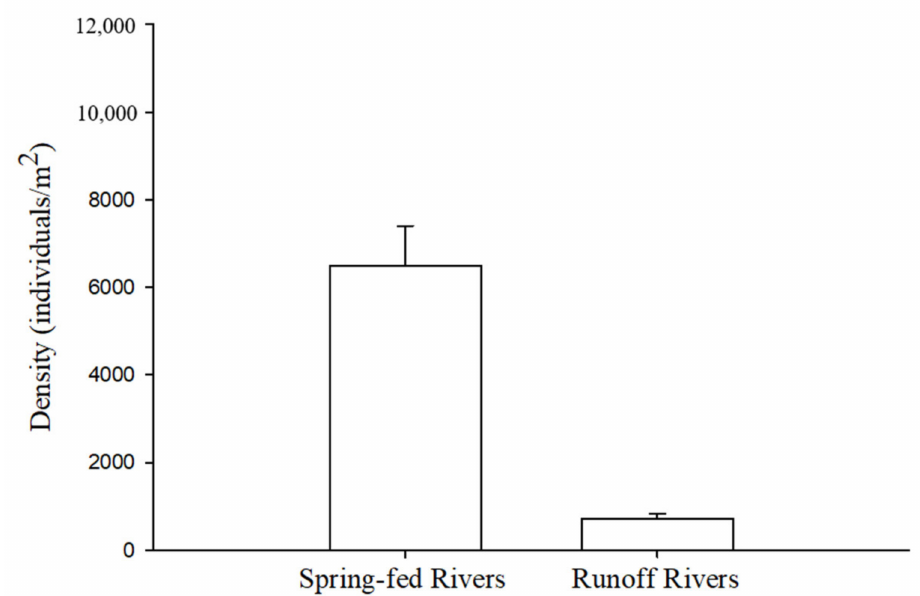
Figure 3. Comparison of invertebrate densities between three volcanic spring-fed rivers and three runoff rivers in northern California, USA. (Adapted from